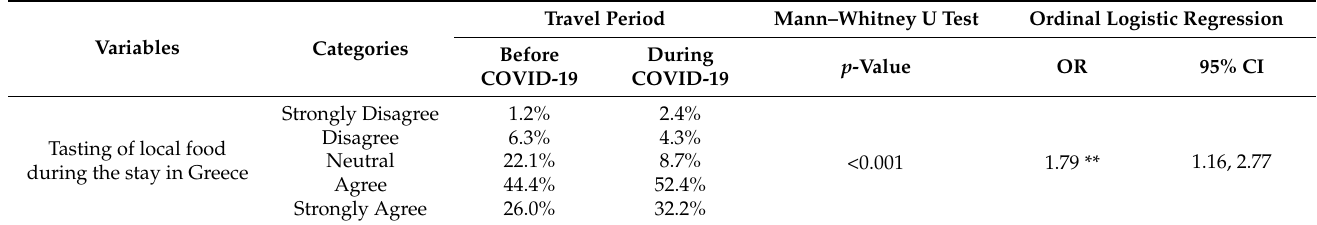
Table 5. Tasting of local food by tourists in each period.